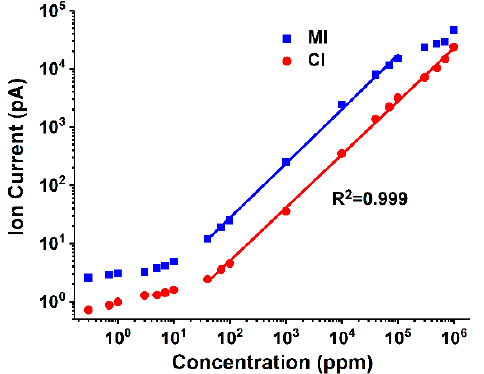
Figure 3. Ion current profiles of ethanol versus sample concentration in MI and CI analysis.